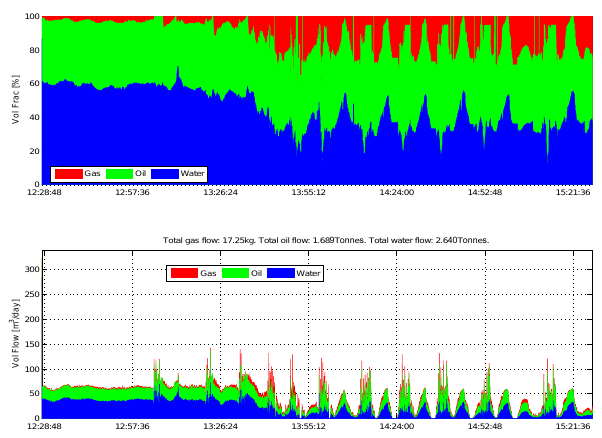
Figure 6. Oil, water and gas measurements from a Russian field trial.